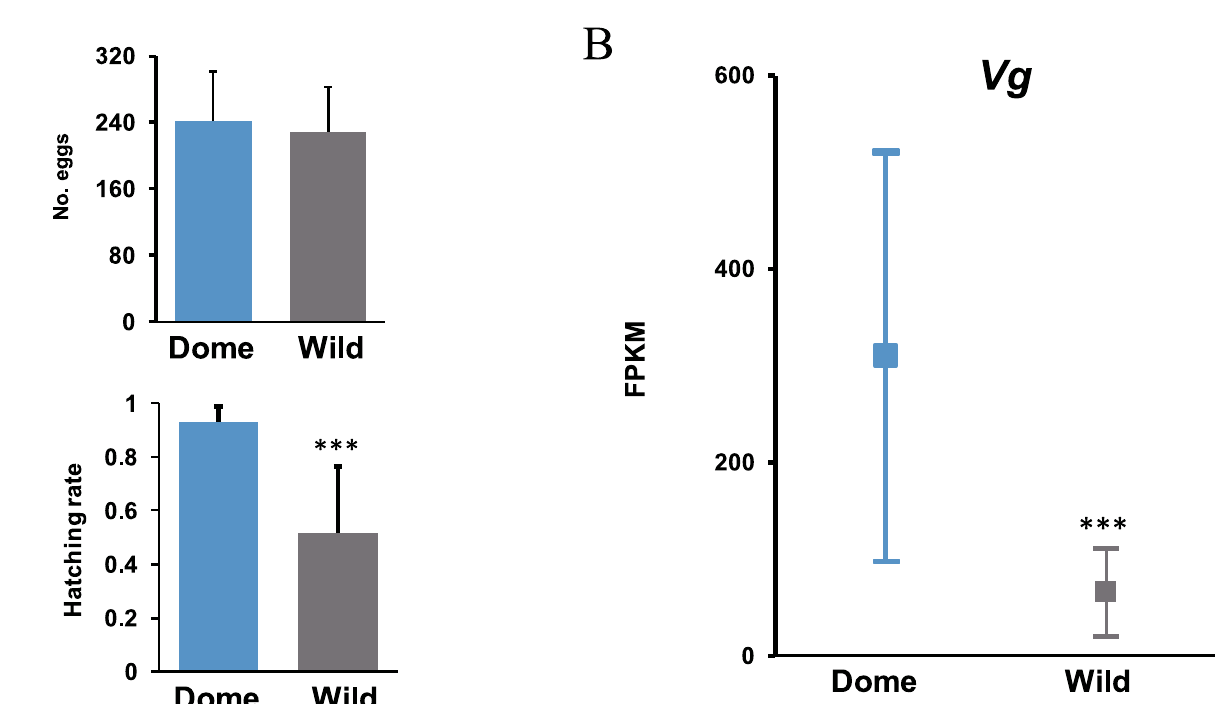
Fig 3. The artificial selection on SP1 might improve silkworm hatching rate during domestication. (A) The egg production and hatching rates in the domestic group and wild silkworms. Error bar: SD. Wild_1 and Wild_2 indicated the results from two repeat times. (B) Expression level indicated as FPKM of Vg in the ova of domestic and wild silkworms. The three data pots indicate the highest value with 95% confidence, the average and the lowest value with 95% confidence, respectively. � , �� and ��� represented significant differences at the 0.05, 0.01, 0.001 level.